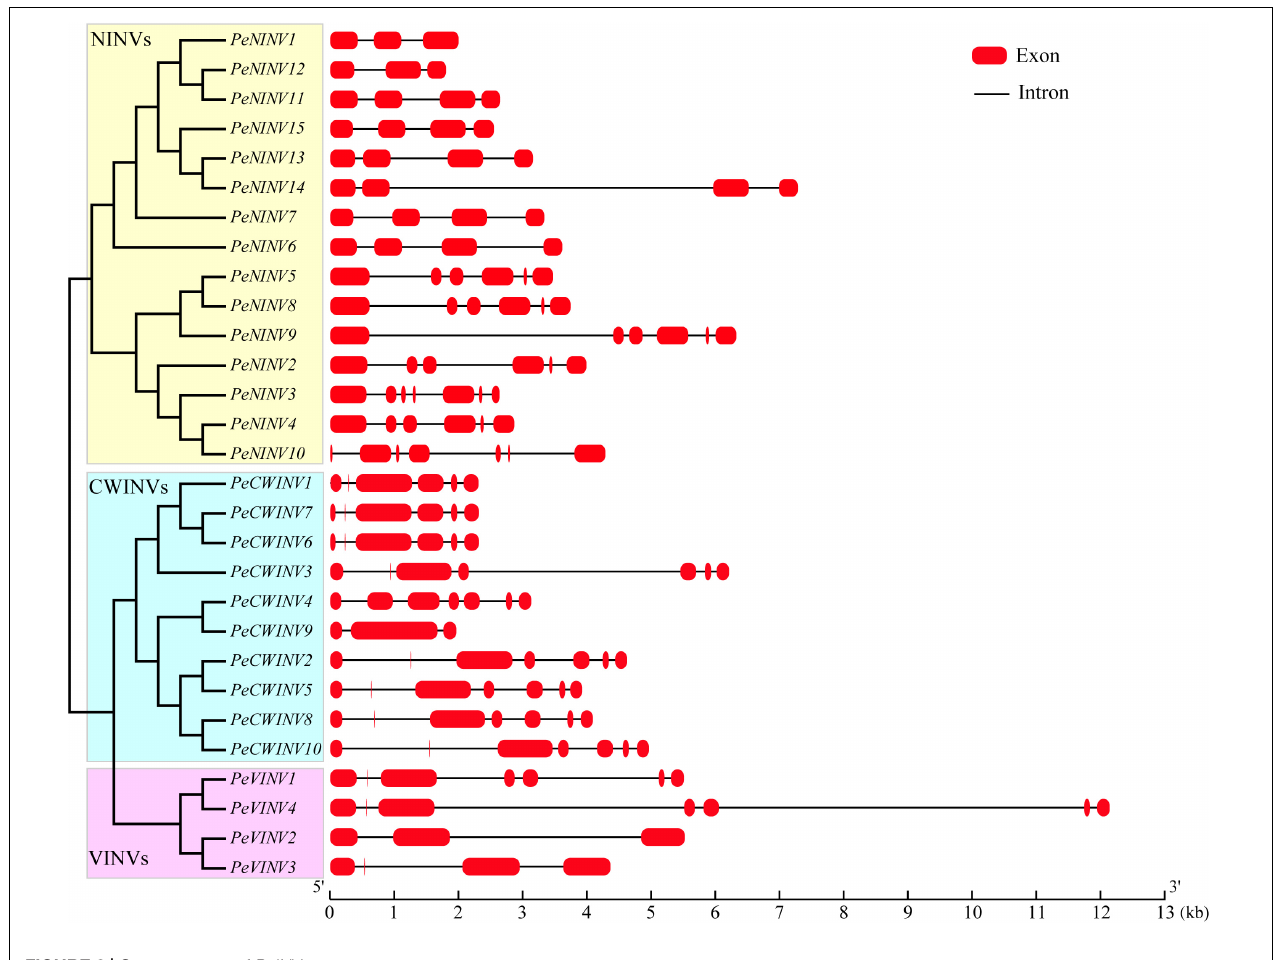
FIGURE 2 | Gene structure of PeINV